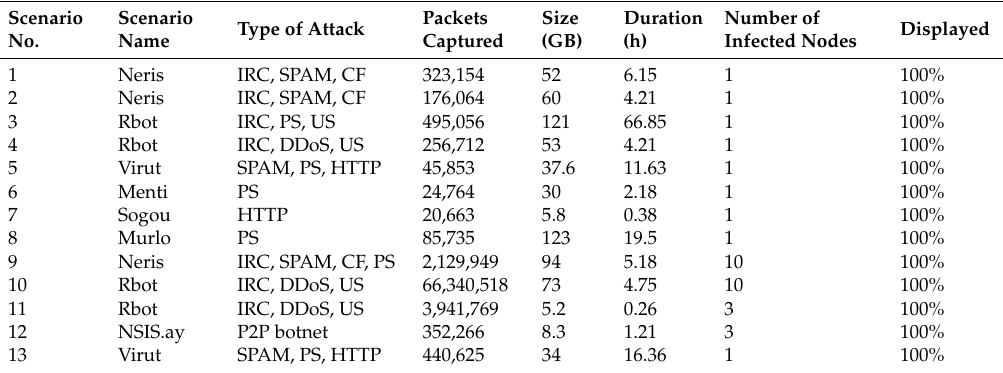
Table 3. Quantitative description of CTU-13